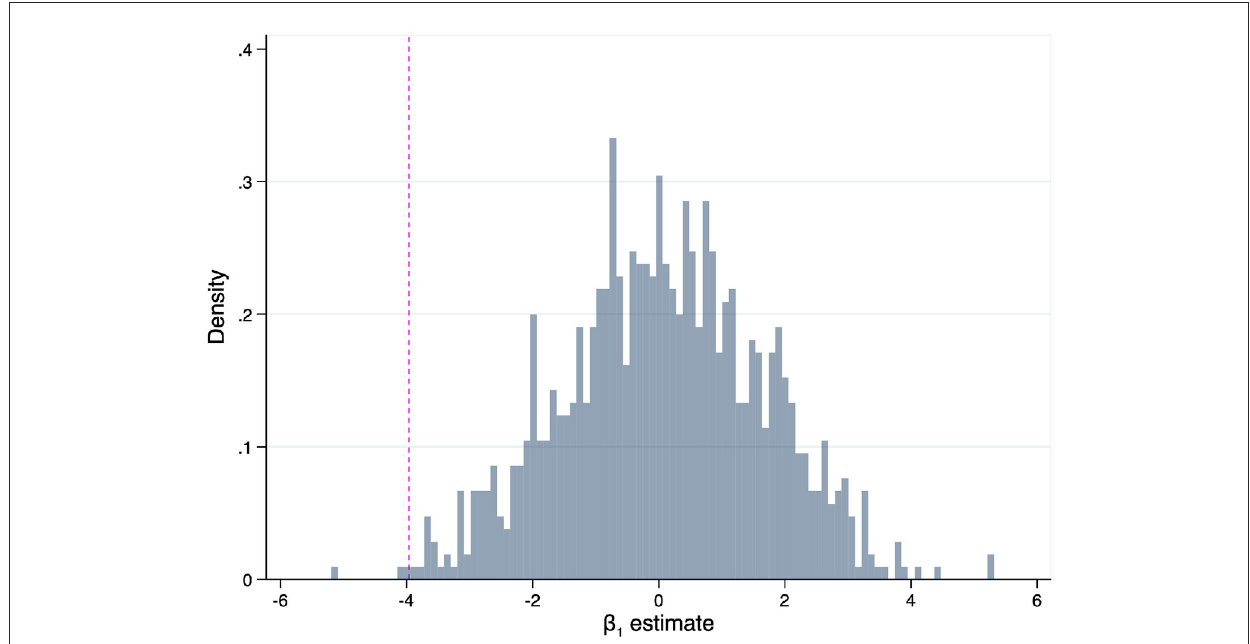
FIGURE4 The falsification procedure randomly re-assigned 1 Q series across states (1,000 pseudo samples). The vertical line marks the 2SLS obtained from the non-falsified sample (Column 2, Table